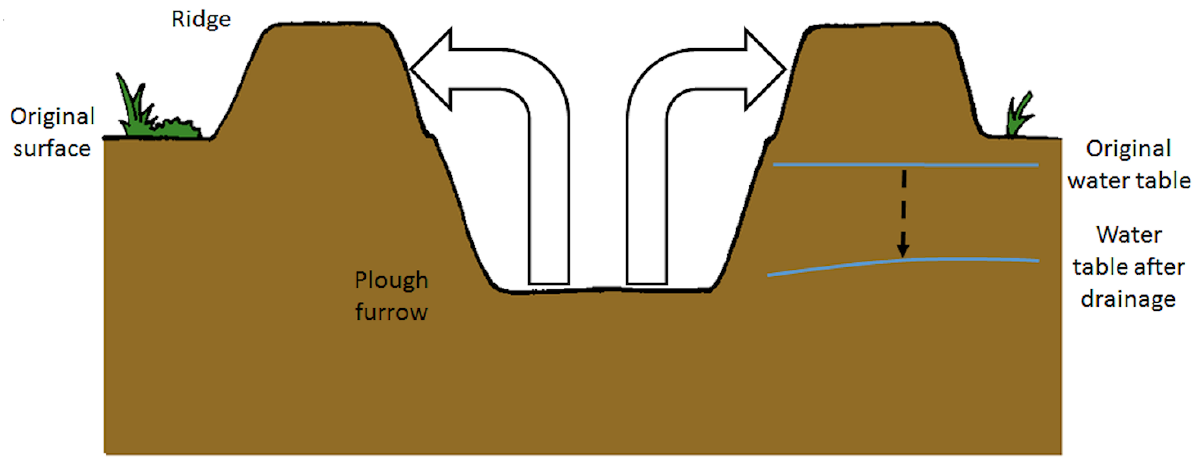
Figure 1. A double mould board plough creates a furrow in the peat and pushes excavated peat into ridges. These ridges are sufficiently raised above the drained water table that the survival chance of planted trees is substantially increased. Unlike the low tillage on Fennoscandian sites, such ploughing on UK forestry sites disturbs the peat and removes much of the bog